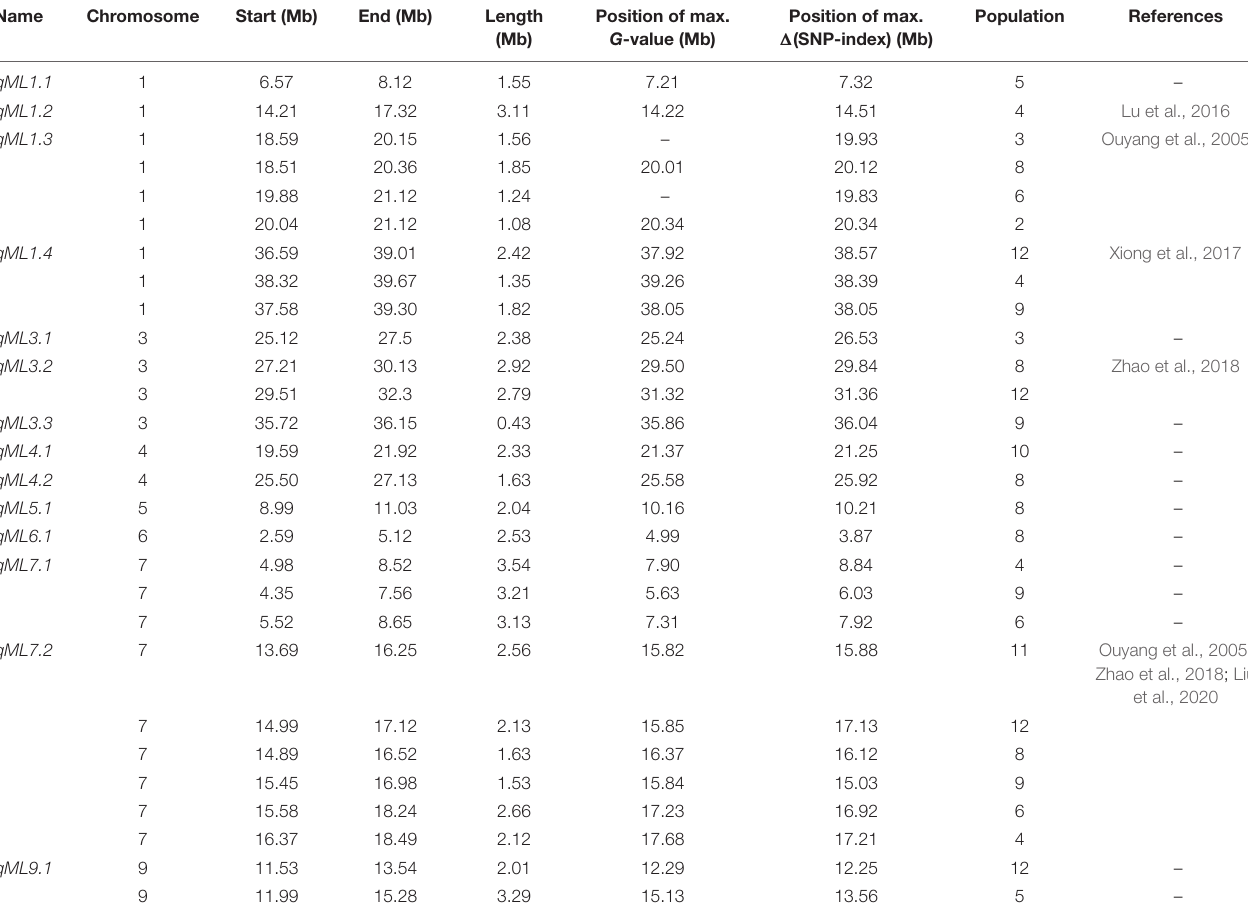
TABLE 2 | QTL-seq for mesocotyl length in 12 F 2